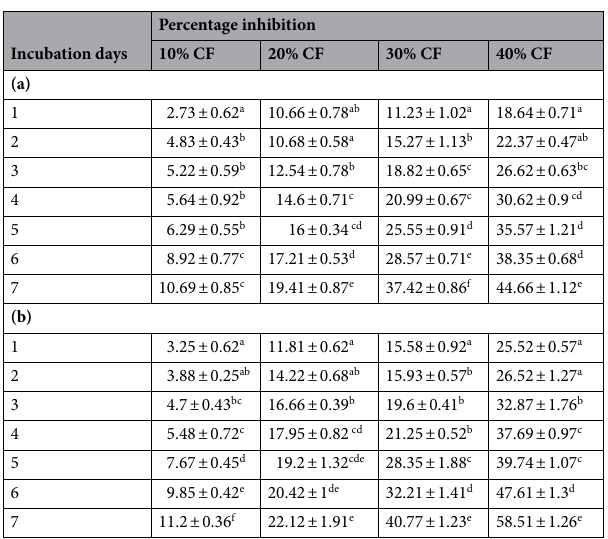
Table 3. Percentage inhibition of culture filtrates (CF) of (a) Trichoderma harzianum and (b) Bacillus subtilis on radial growth of Fusarium oxysporum . In each column, significantly different values by Tukey’s HSD test ( p < 0.05) are marked by different lowercase letters. Values are depicted with standard deviation for n = 3.